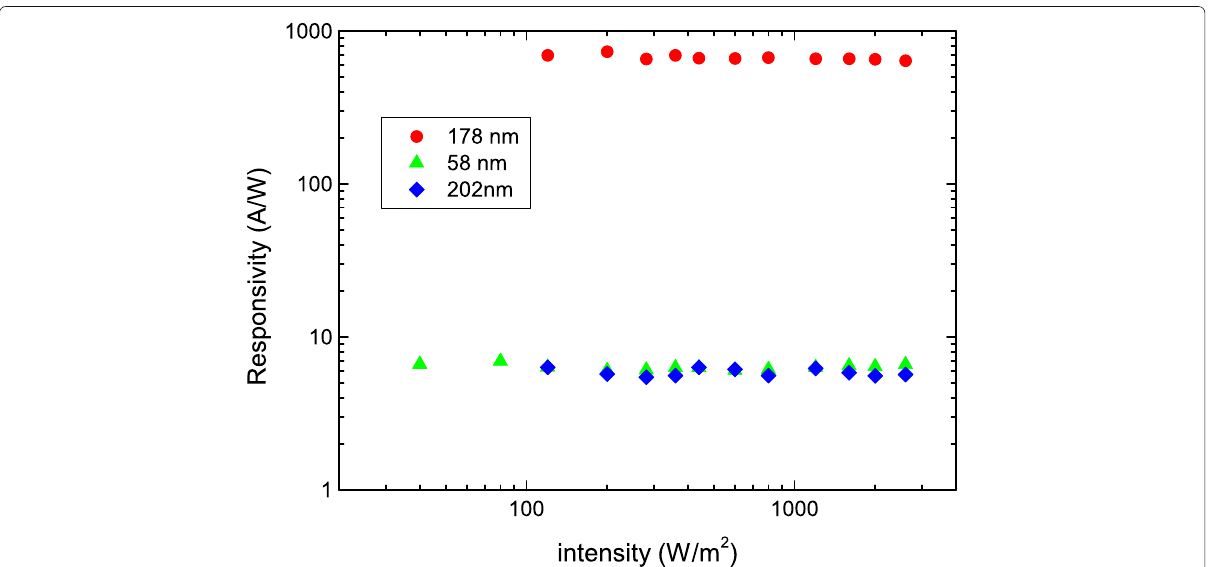
Fig. 3 The responsivity of three Sb 2 Se 2 Te nanosheets. It reveals weak dependence of the light power intensity on responsivity. The higher responsivity is observed in the nanosheet with higher